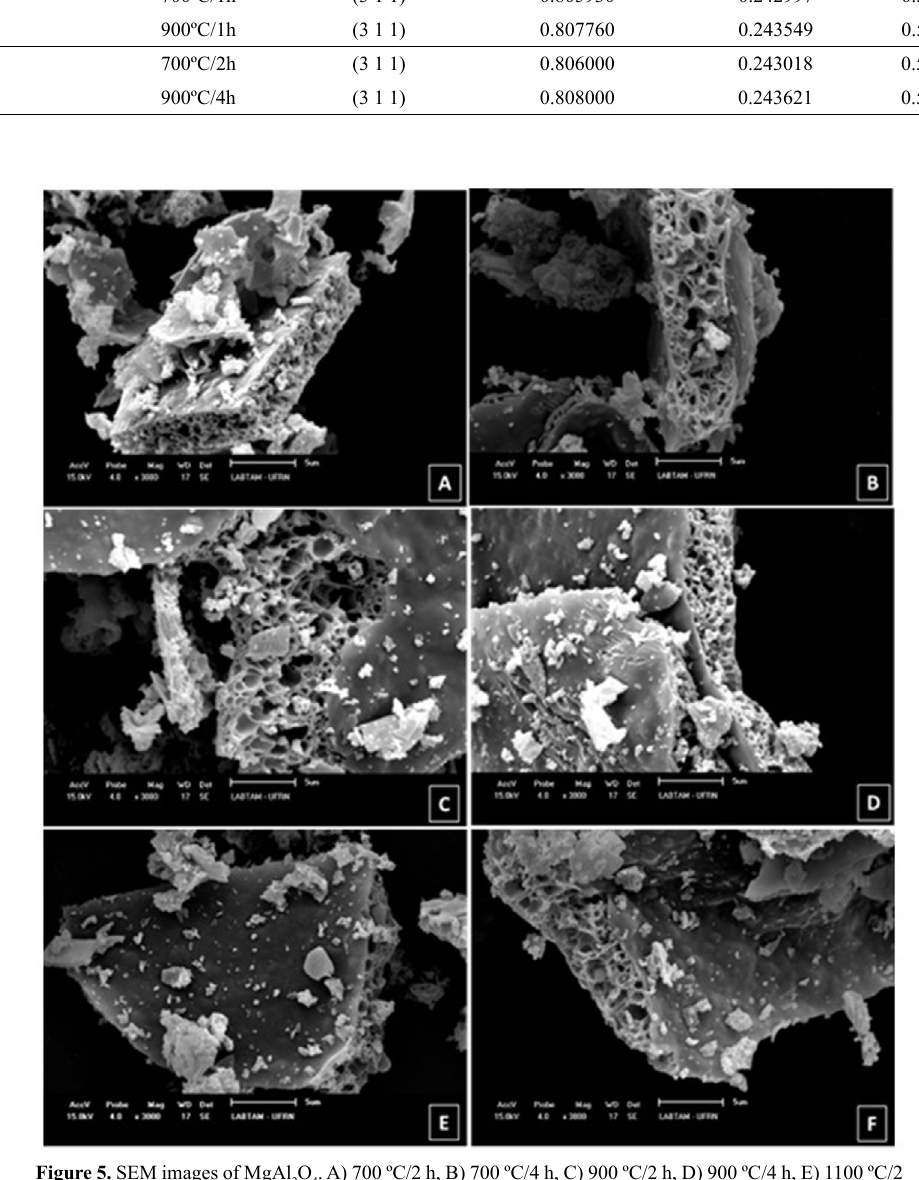
Figure 5. SEM images of MgAl h and F) 1100 ºC/4